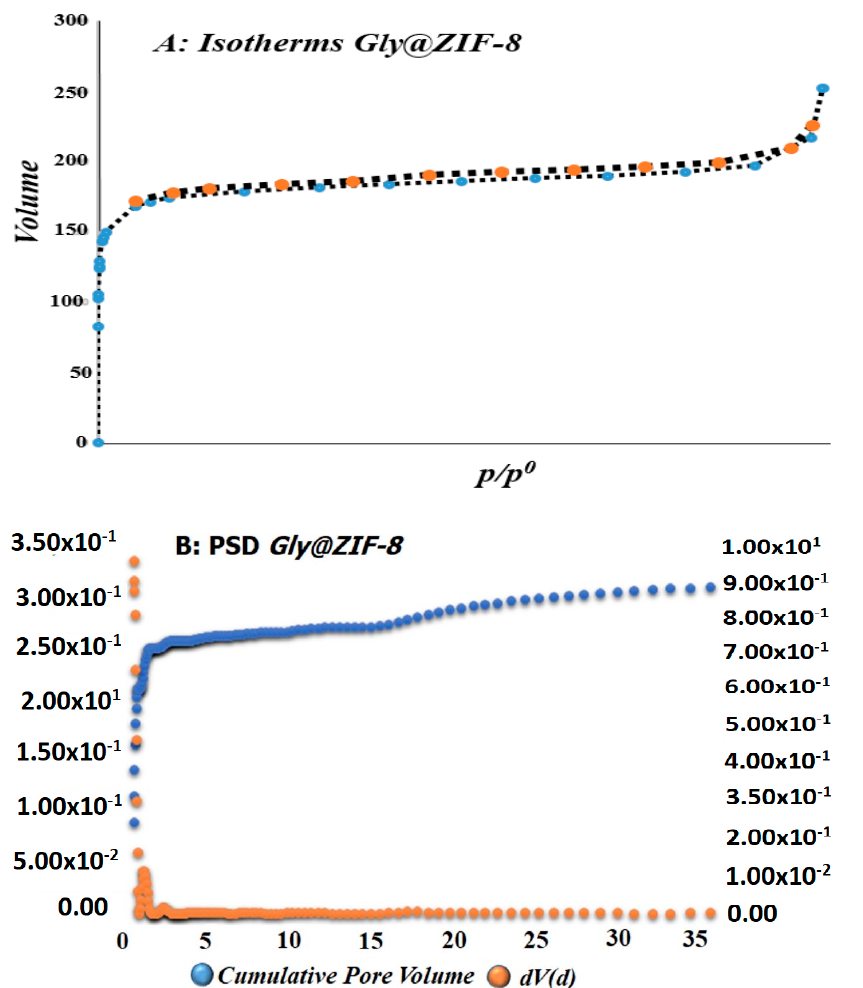
Figure 1. ( A ) Adsorption–desorption isotherms of N 2 at 77 K of Gly@ZIF-8. ( B ) Pore size distribution curves.